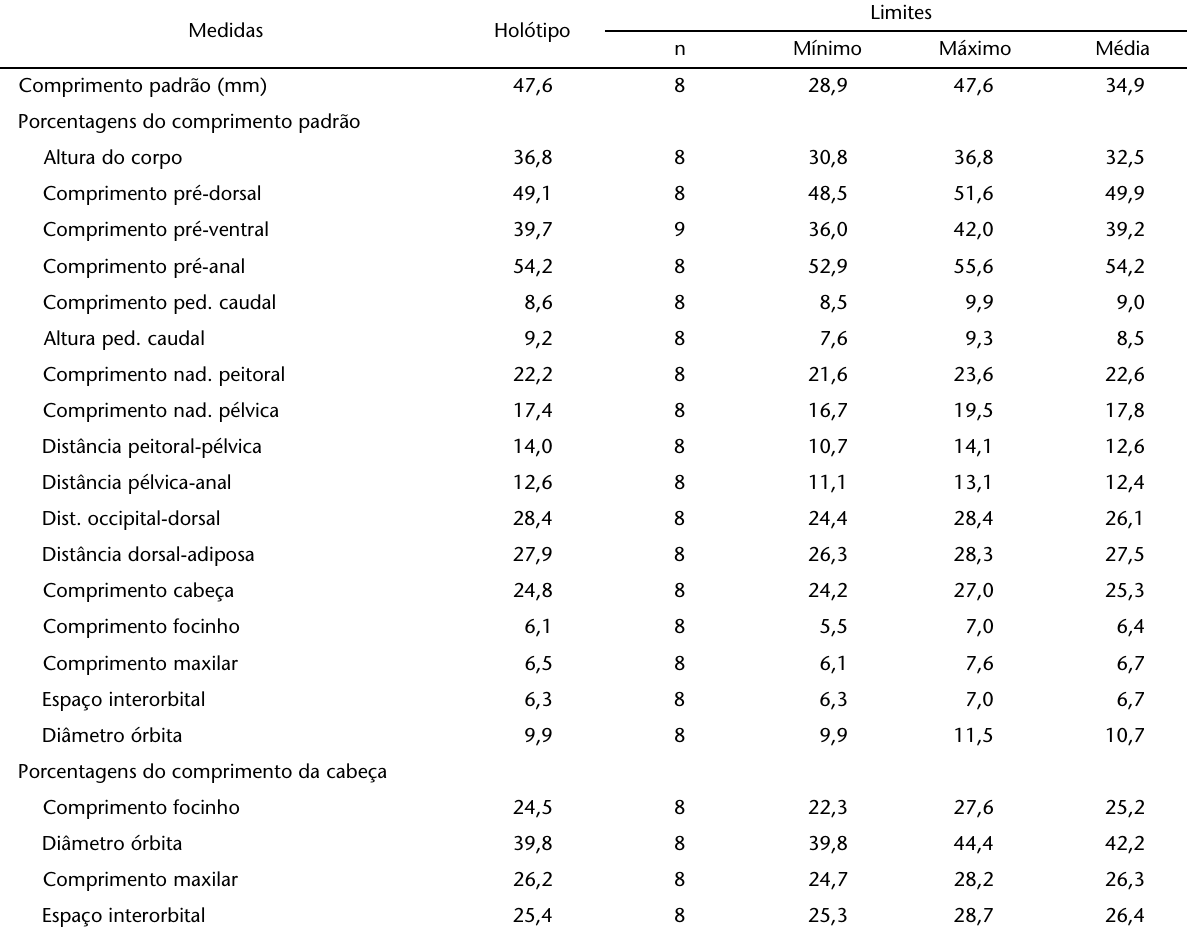
Coloração em vida. Conforme P LANQUETTE et al.